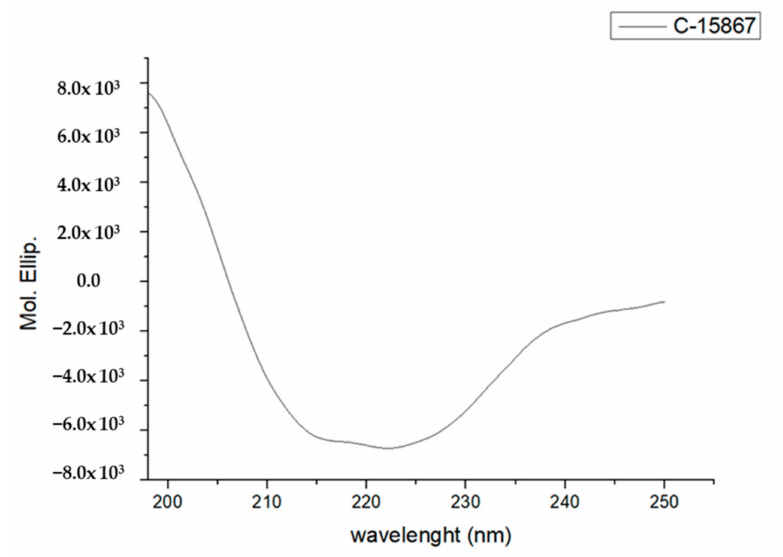
Figure 4. CD spectrum of the native C-15867 peptide in PBS